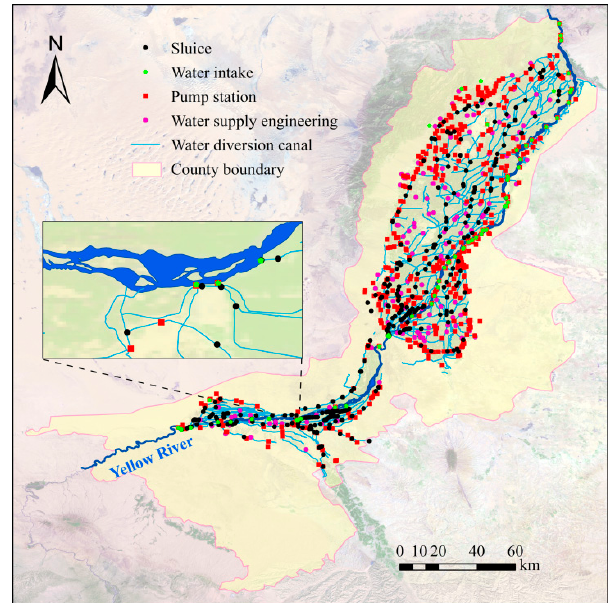
Figure 11. Distribution of the engineering facilities in the irrigation areas along both banks of the NRYR.